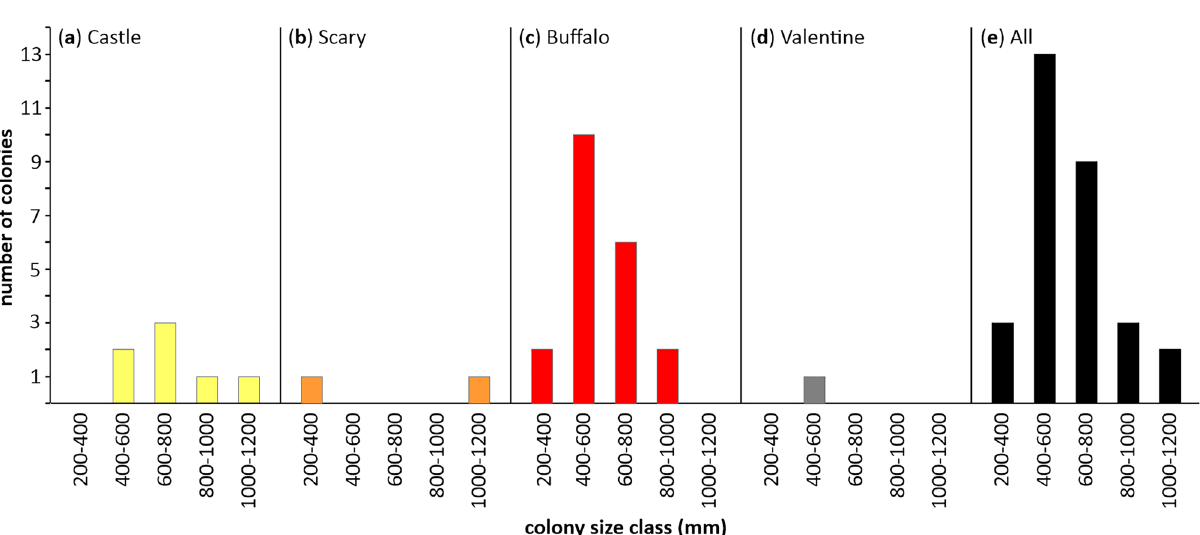
Figure 5. Coral colony size structure of the Angolan Madrepora oculata population. The number of M. oculata specimens for each defined colony size-class (given in mm) is depicted in this graph. They were documented for the Angolan mounds: ( a ) Castle, ( b ) Scary, ( c ) Buffalo, ( d ) Valentine, and ( e ) displays a compilation of all mounds.